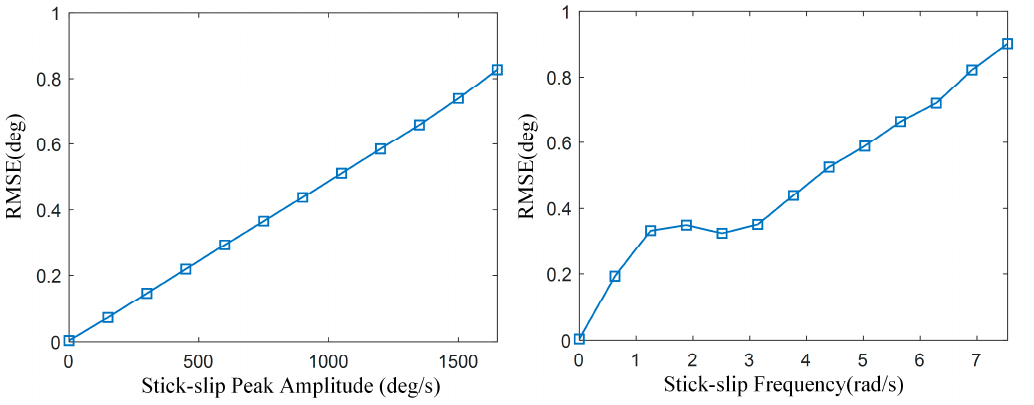
Figure 17. Toolface tracking errors in the presence of stick-slip.